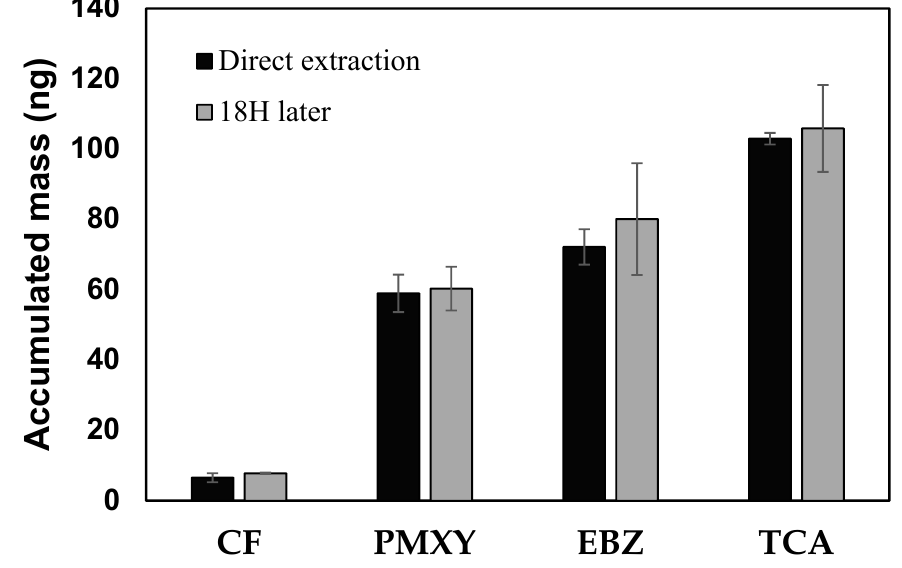
Figure4. Accumulatedmassintheresinofthesolidceramicdosimeterbydirectextractionandextraction Figure 4. Accumulated mass in the resin of the solid ceramic dosimeter by direct extraction and after 18 h. Error bars represent the standard deviation (n = 5). extraction after 18 h. Error bars represent the standard deviation (n = 5).